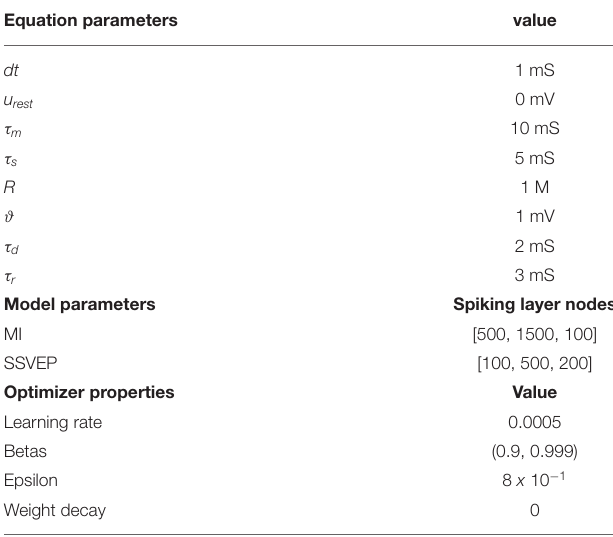
TABLE 1 | List of parameters in the model equations, the spiking neural network (SNN) architecture, and the optimizer. Equation parameters